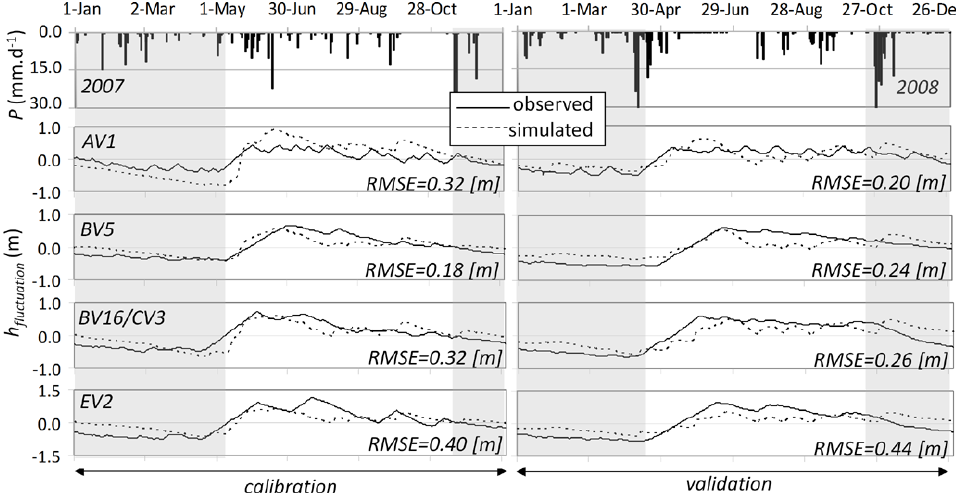
Fig. 7. Observed and simulated groundwater level fluctuations over years 2007 (calibration period) and 2008 (validation period) with corre- sponding root-mean-squares errors values (RMSE). The 0 at the y-axis corresponds to average observed or simulated groundwater level. The shadow areas correspond to the period when the snow cover was